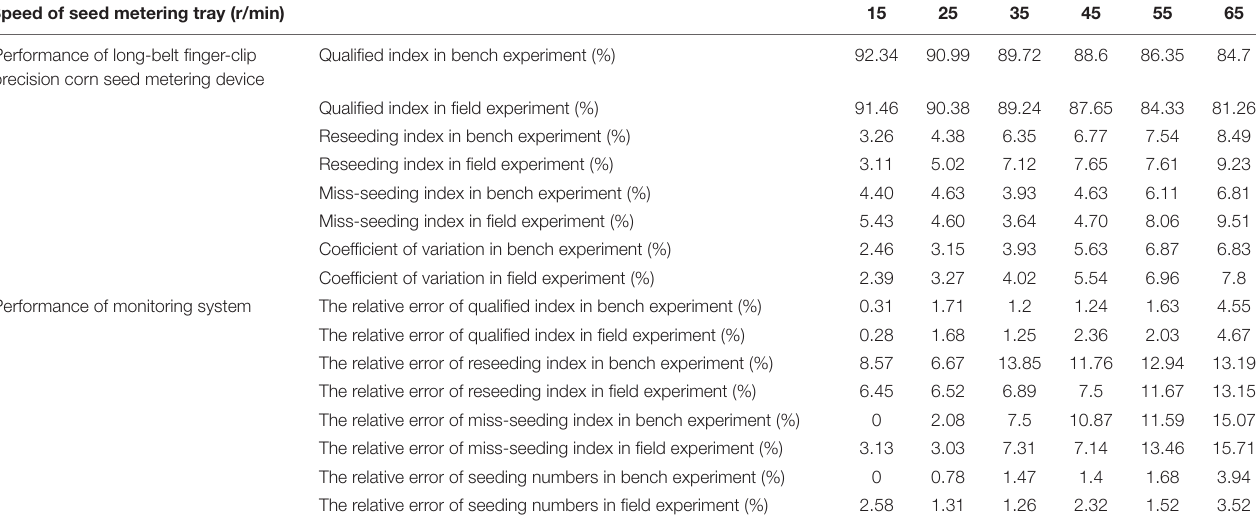
FIGURE 10 | Influence of the rotating speed of the seed metering tray on the monitoring accuracy of the sensor. (A) Qualified number in bench experiment. (B) Reseeding number in bench experiment. (C) Miss-seeding number in bench experiment. (D) Seeding amount in bench experiment. (E) Qualified number in field experiment. (F) Reseeding number in field experiment. (G) Miss-seeding number in field experiment. (H) Seeding amount in field experiment. TABLE 2 | Comparison results between bench experiment and field experiment of long-belt finger-clip precision corn seed metering device and monitoring system. Speed of seed metering tray